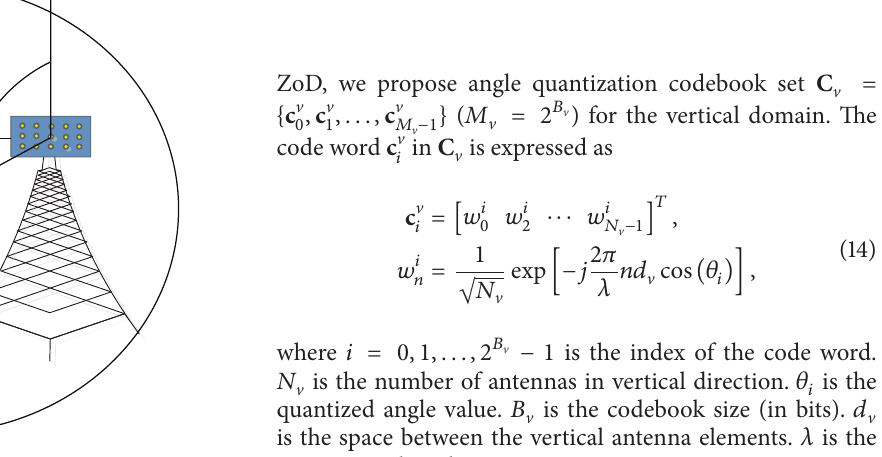
Figure 5: The definition of ZoD.